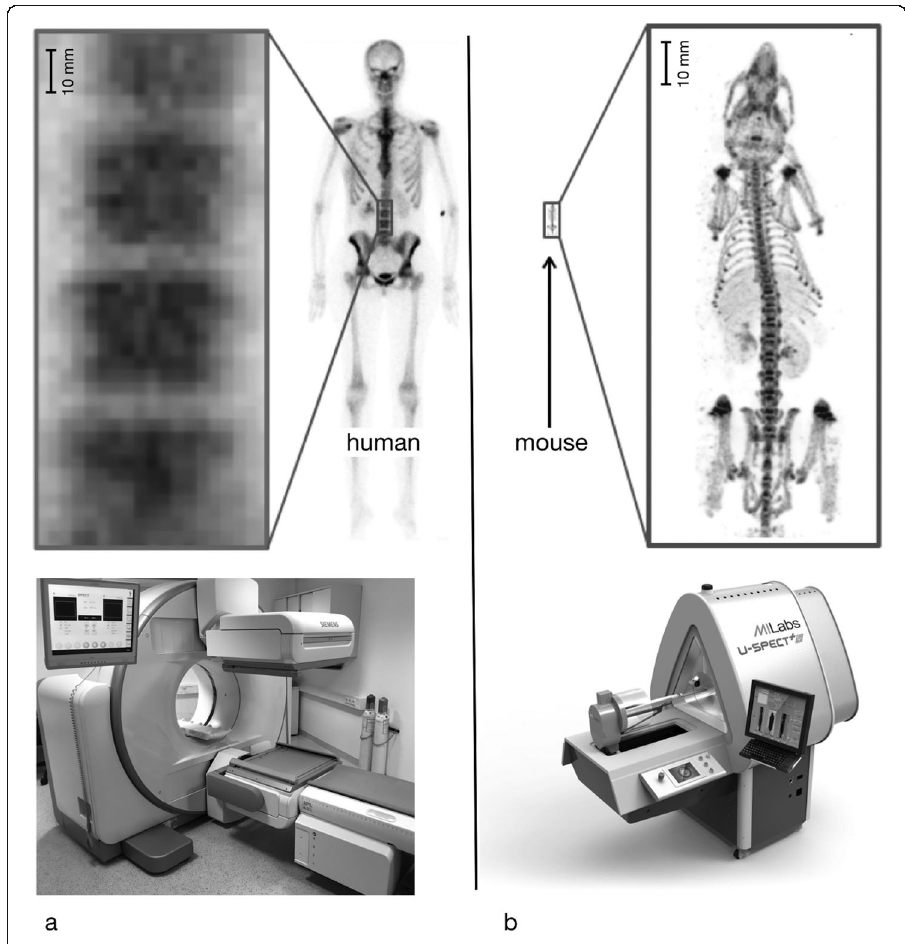
Fig. 2 Spatial resolution performance comparison in SPECT between a clinical ( a ) system and a preclinical system (courtesy of MILabs B.V) (Ivashchenko et al. 2015) ( b